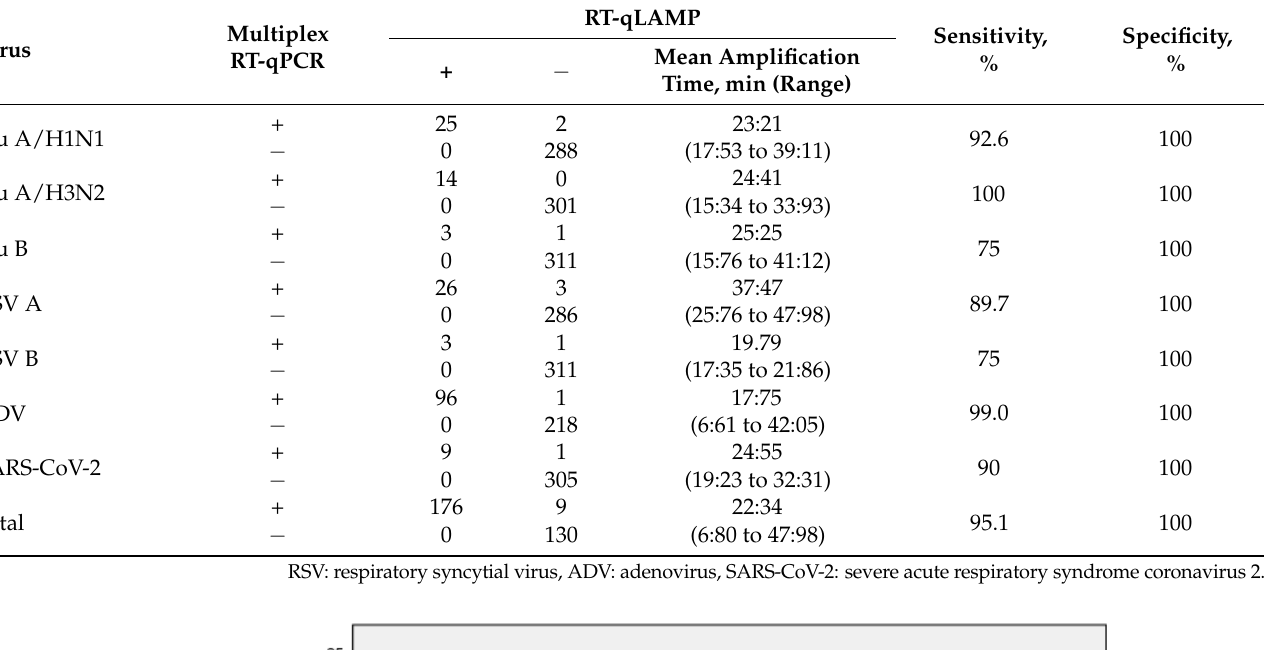
Table 2. Comparison of the results between the developed RT-qLAMP and RT-qPCR performed concurrently.